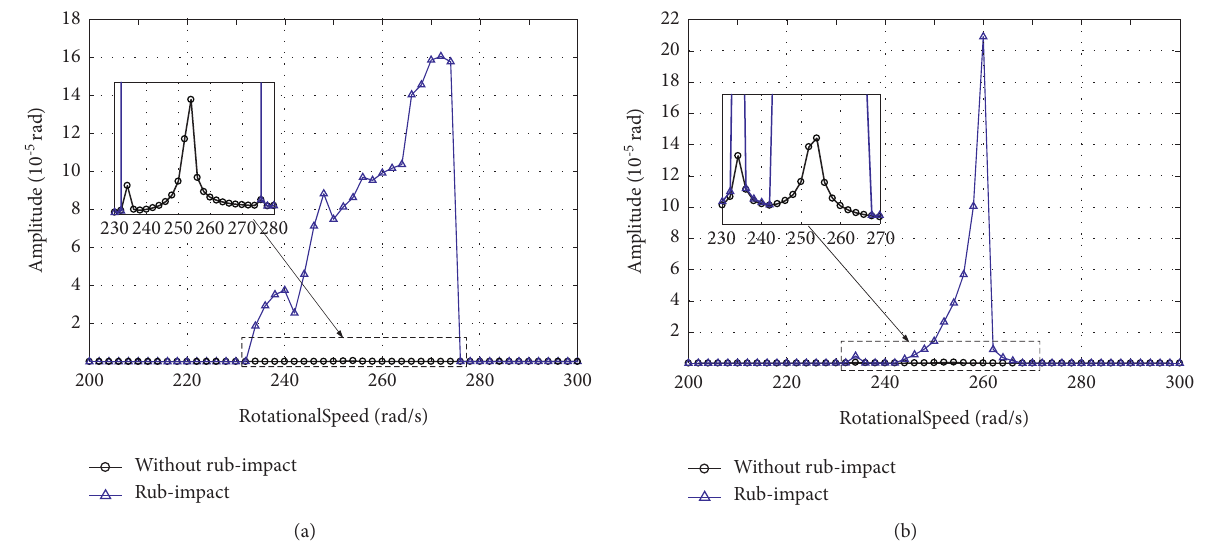
Figure 11: Torsional vibration response of disk 4 with or without rub-impact. (a) Level flight. (b) Hovering